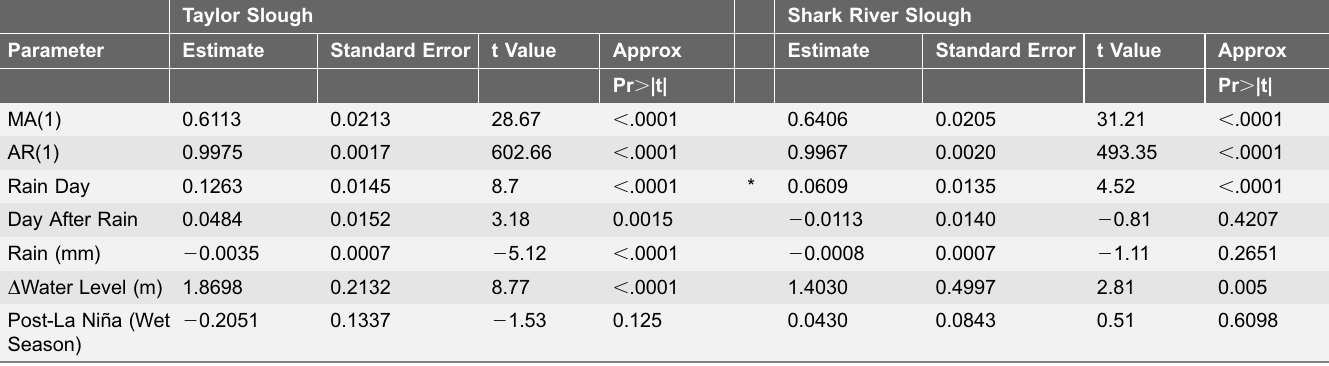
Table 6. Parameter estimates from ARIMA models of daily GEE by site.